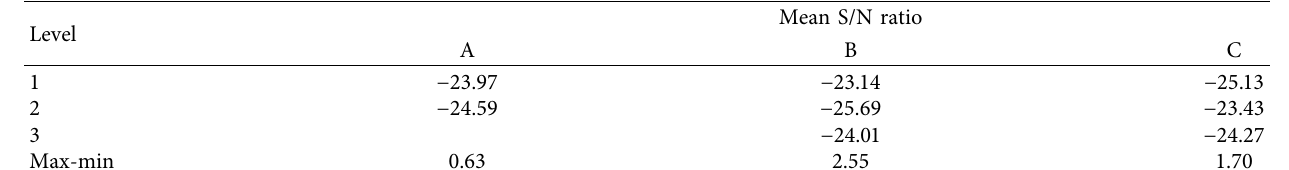
Table 6: S/N response.